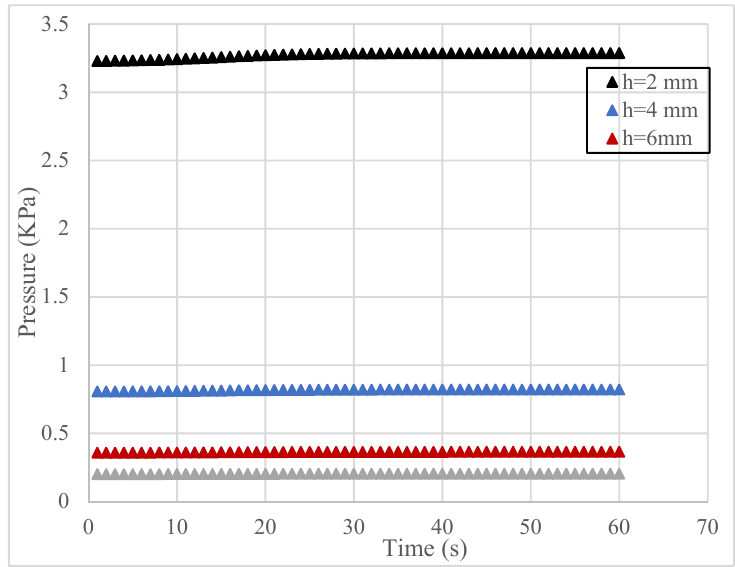
Figure 12. Variation curve of pressure with time under different fracture opening.